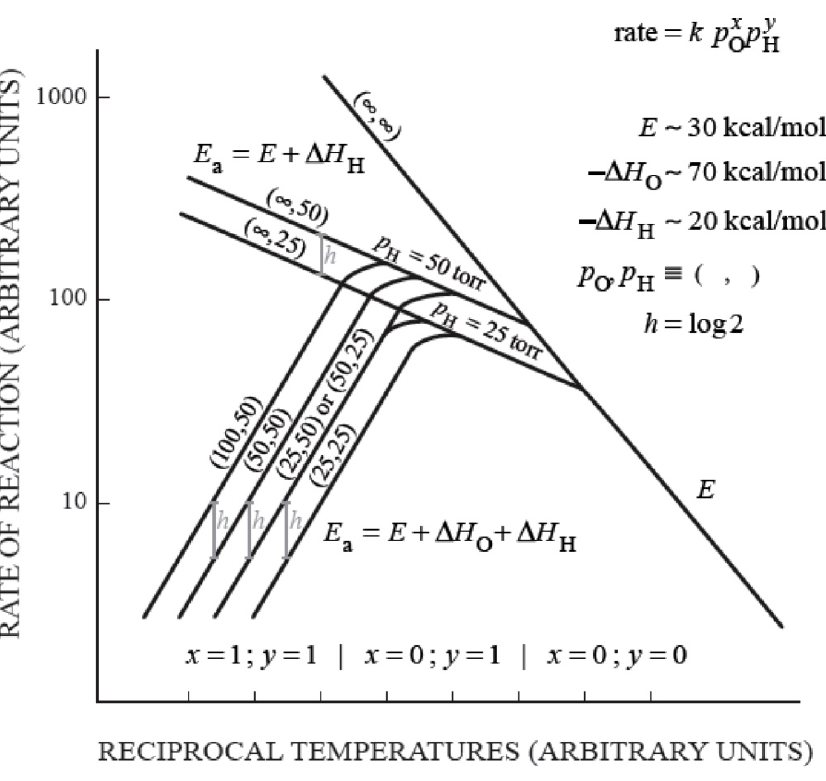
Figure 6. Scheme showing the Arrhenius plot observed in carbon formation from olefins (O) and hydrogen (H) on Ni under various pressures, as indicated (p o -olefin, p H -hydrogen). The negative apparent activation energy E a observed above 550 ◦ C is due to the surface reaction controlling the rate with negative values of the reactant’s adsorption enthalpies ( E a = E + ∆ H O + ∆ H H ) and reaction orders: x = 1, y = 1 [9].